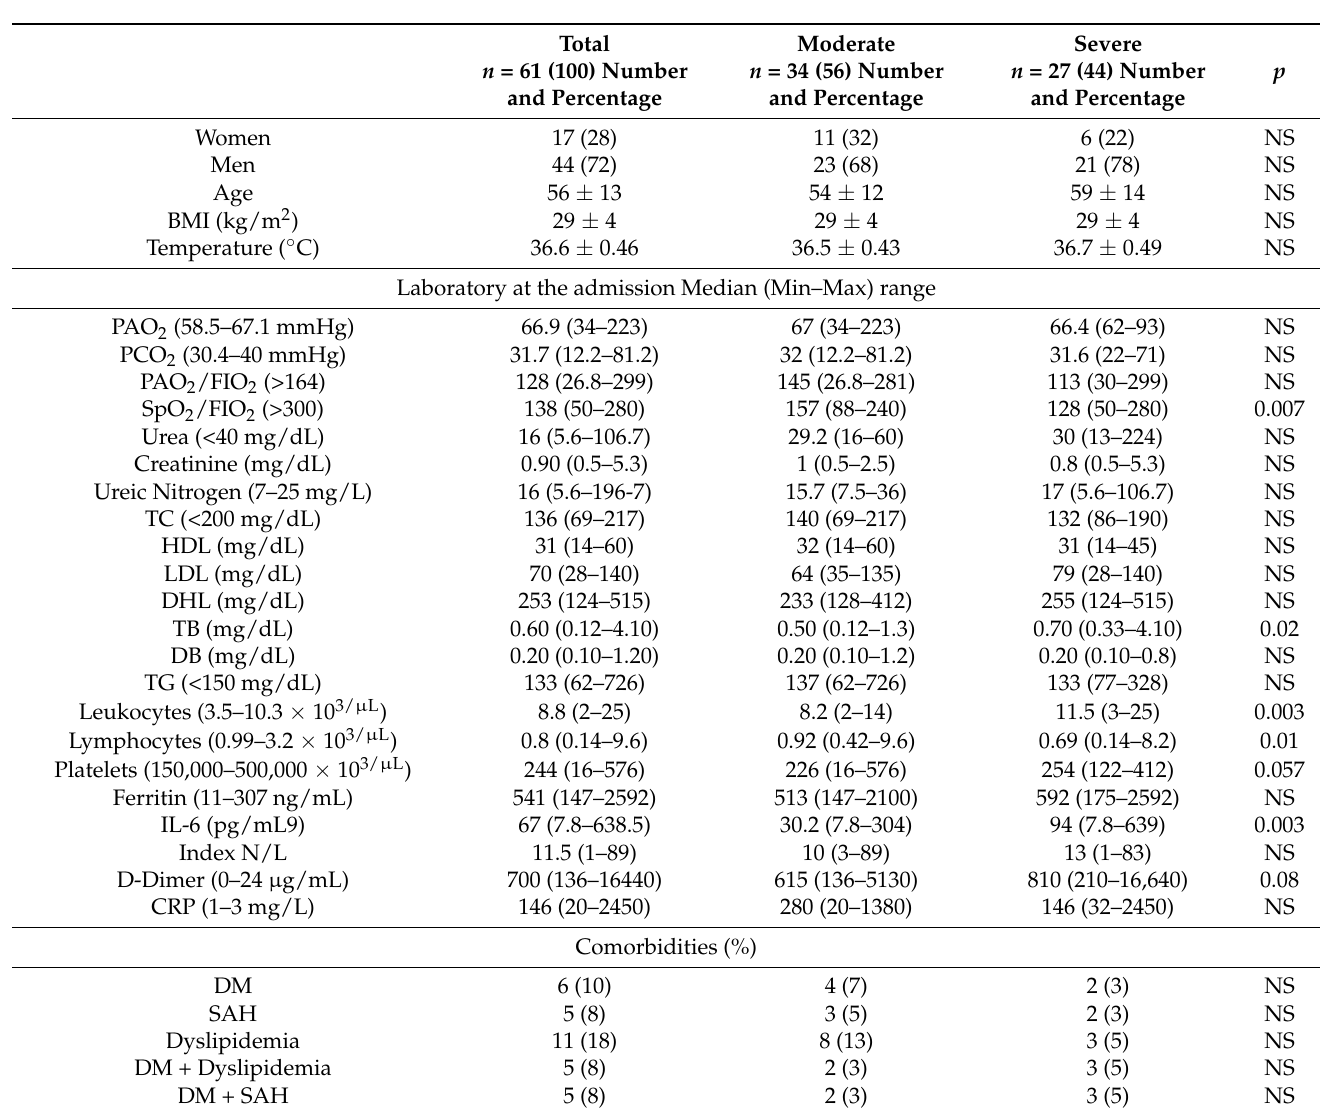
Table 1. Demographic characteristics at admission of patients infected with COVID-19. Total n = 61 (100) Number and Percentage